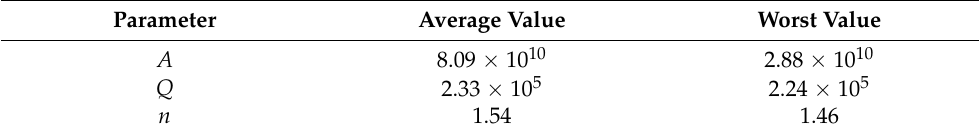
Table 3. Calculation results of parameters in Equation (2).